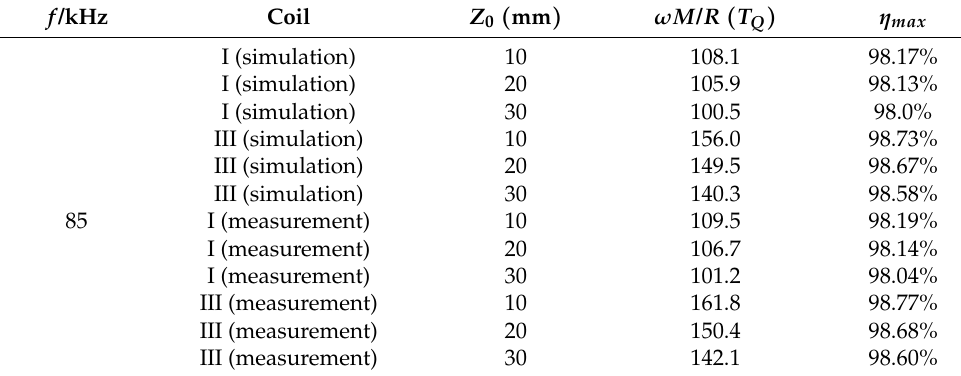
Table 3. Performance comparison of optimized coils with